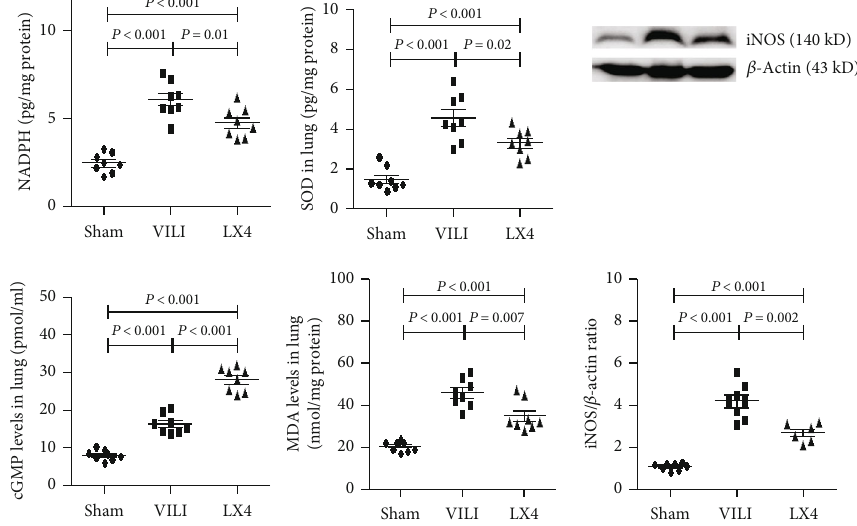
Figure 5: Lipoxin A4 reduced the oxidative stress response after VILI. In the VILI group, the activity of NADPH and SOD and the concentrations of cGMP and MDA were promoted by large-volume MV. Compared to the VILI group, NADPH and MDA were reduced by lipoxin A4, and cGMP and SOD were increased by lipoxin A4. ∗ P < 0 : 05 , vs. the sham group; # P < 0 : 05 , vs. the VILI group. ● : sham group; ■ : VILI group; ▲ : LX4